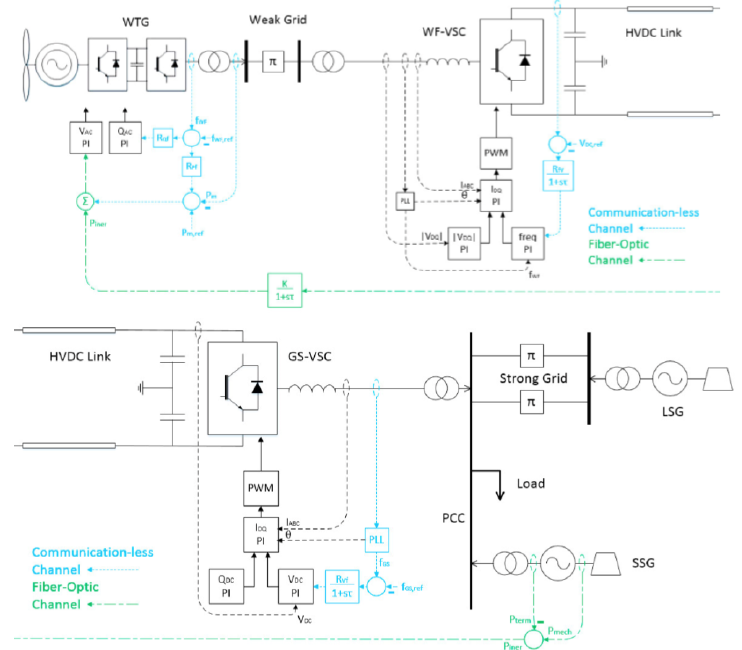
Figure 9. Offshore reference circuit proposed by